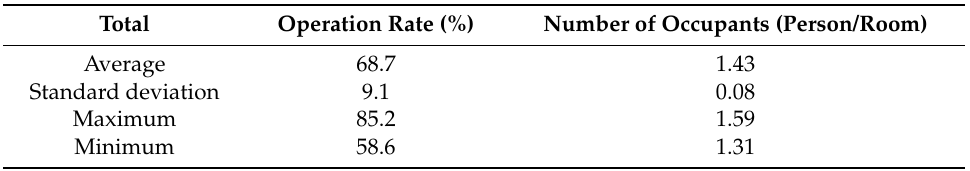
Table 2. The operation rate and occupants per